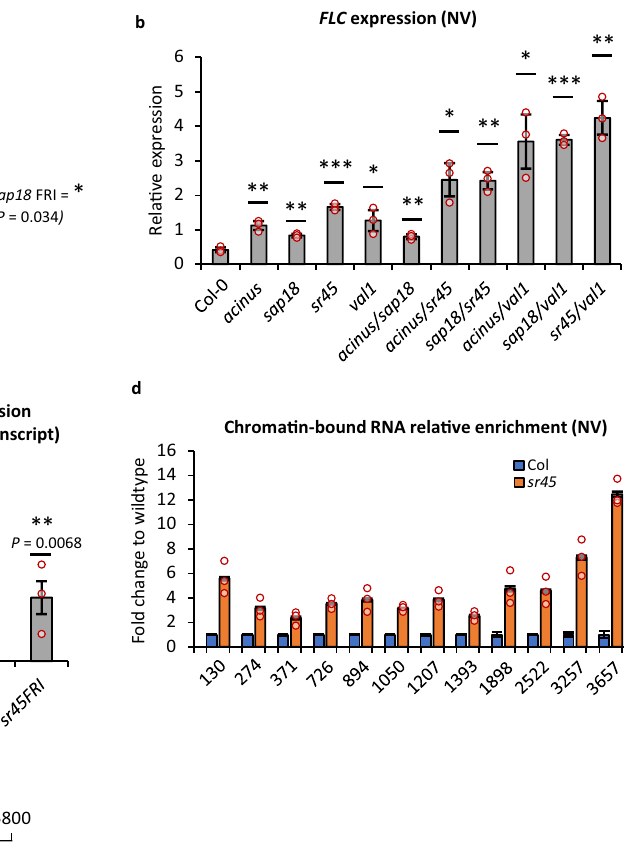
Fig. 2 | ASAP mutants affect FLC transcription in warm conditions. a FLC downregulation (spliced transcript) during vernalization (fold change to NV). Values were normalized as relative expression to UBC . N =3 biological replicates, errorbars=propagated SEM. NV non-vernalized,2/4/6W 2/4/6 weeks cold, 6 WT7 6 weeks cold followed by 7 days in warm. P value for sap18 FRI at 6 WT7 0.0344. b FLC expression (spliced transcript) in ASAP single mutants and different double mutant combinations combining different ASAP mutants or ASAP mutants with val1 . Values correspond to the mean relative expression to UBC . N =3 biological replicates; error bars=SEM. c FLC expression in sr45 in a vernalization-dependent